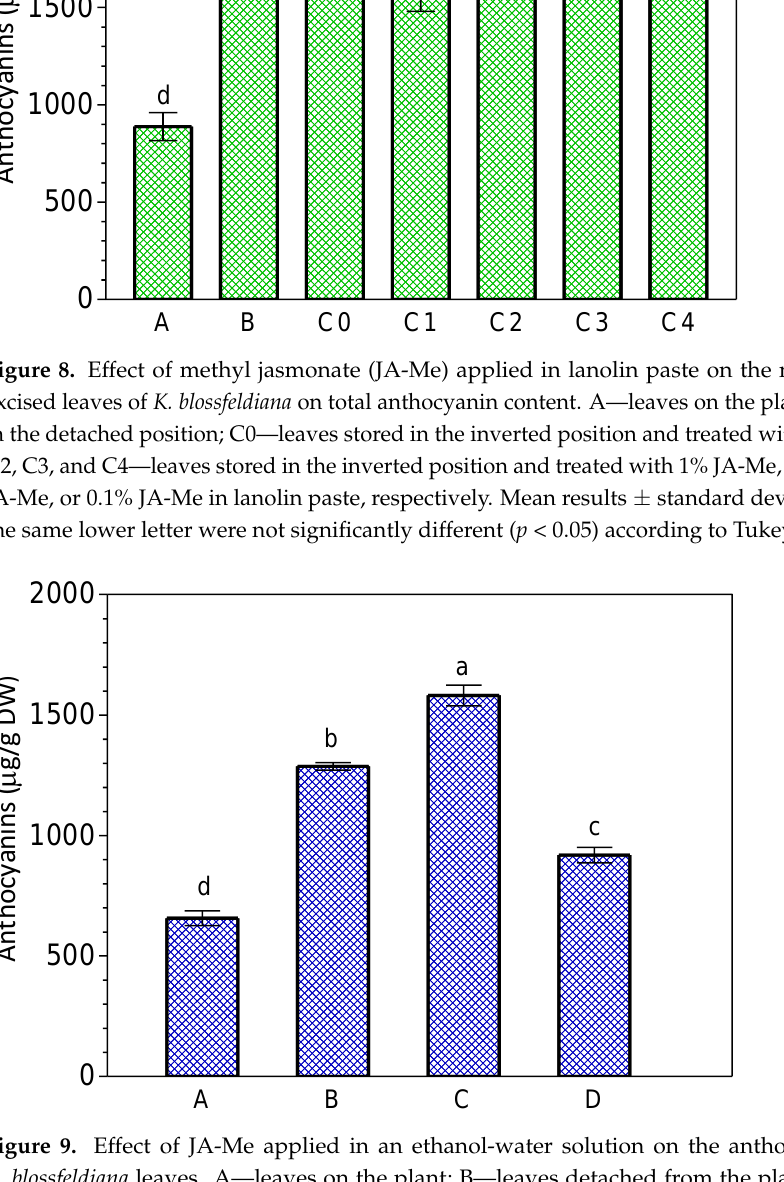
Figure 9. Effect of JA-Me applied in an ethanol-water solution on the anthocyanin content of K. blossfeldiana leaves. A—leaves on the plant; B—leaves detached from the plant, treated for 1 h with water, and kept in the inverted position; C—leaves detached from the plant, treated for 1 h with an ethanol-water solution, and kept in the inverted position; D—leaves detached from the plant, treated for 1 h with 10 − 3 M JA-Me in an ethanol-water solution, and kept in the inverted position. Mean results ± standard deviation followed by the same lower letter were not significantly different ( p < 0.05) according to Tukey’s test.